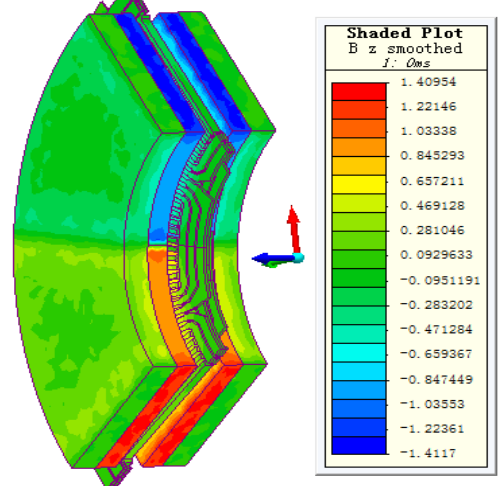
Figure 7. Flux density distribution of the motor.